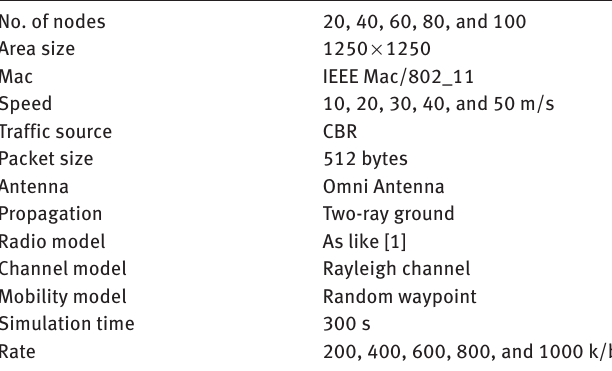
Table 1: Simulation